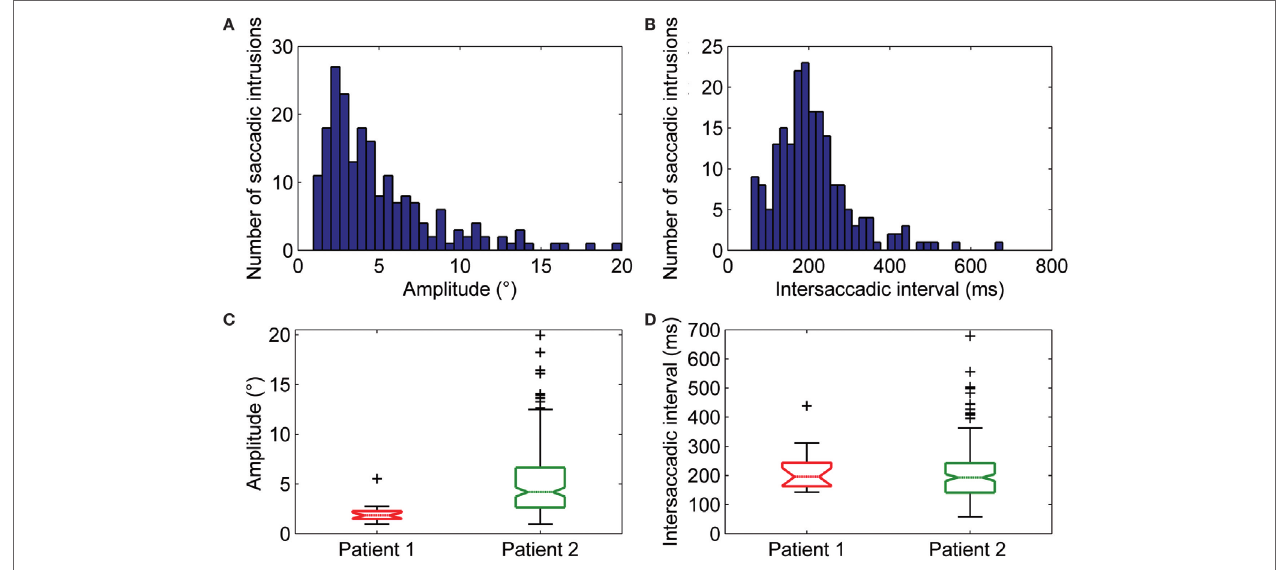
FigUre 4 | (a) Amplitudes and (B) intersaccadic intervals distribution of square-wave jerks (SWJs). The x -axis in (a,B) represents bins of amplitudes and intersaccadic interval, respectively; the y -axis represents the number of the SWJs for the given bin. The box and whisker plots show summaries of the amplitudes (c) and intersaccadic intervals (D) of all SWJs in Patient 1 and Patient 2. The central horizontal bar in each box represents the median, lower, and upper borders are the lower and upper quartile values, whiskers indicate the 95% confidence interval around the median, and outliers ( + ) are shown